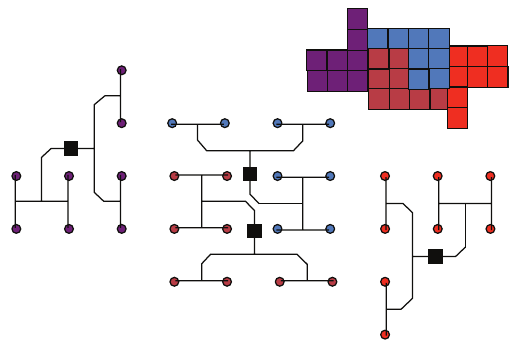
Figure 6: L-octomino power divider and array section.